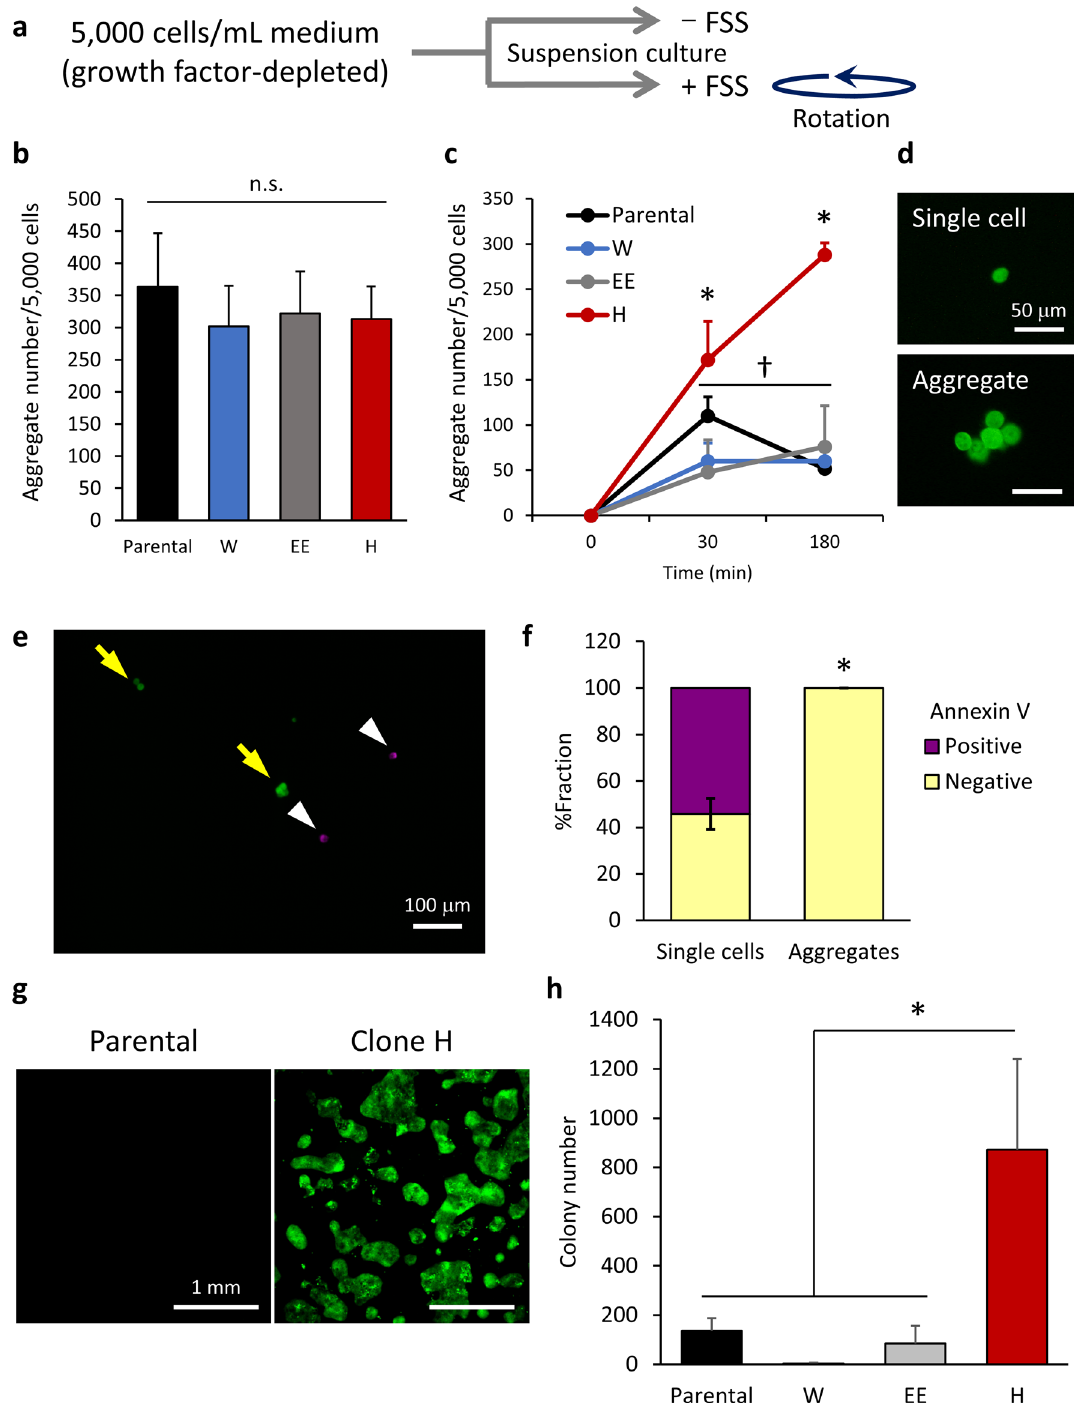
Figure 4. A DTC-dominating clone efficiently forms anoikis-resistant aggregates under FSS conditions. ( a ) Diagram showing the experimental setup of the anoikis assay. Single cells (5 × 10 3 ) obtained from SAS-GL cells (parental), clone W, and clone H were separately suspended in culture medium and then cultured on poly-HEMA-coated plates under static conditions (−FSS) or rotated (+FSS) at 37 °C. ( b ) Numbers of aggregates in suspension culture at 18-h under static conditions. Values are means ± SEM of triplicate samples. n.s., not significant. ( c ) Numbers of aggregates generated in suspension culture under FSS conditions. Values are means ± SEM of triplicate samples. * p < 0.005 (two-tailed t tests). ( d ) Representative images of single cells (upper panel) and aggregates (lower panel) derived from clone H cultured under FSS conditions. ( e ) Annexin V staining with clone H cells at 3 h of suspension culture. Arrows and arrowheads indicate annexin V-negative aggregates and -positive single cells, respectively. ( f ) Proportion of annexin V-positive and -negative cells in single cells and aggregates. * p < 0.0001 (Pearson’s χ 2 test). ( g , h ) Single cells (5 × 10 4 ) were suspended in culture medium and rotated for 22 h at 37 °C. Cells were centrifuged, plated in 6-well plates, and cultured for 6 days. Colonies of surviving cells with areas > 2500 μm 2 were counted. ( g ) Representative images of colonies. ( h ) Number of colonies derived from parental cells and clones W, EE, and H. Values are means ± SEM of triplicate samples. * p < 0.05 (two-tailed t